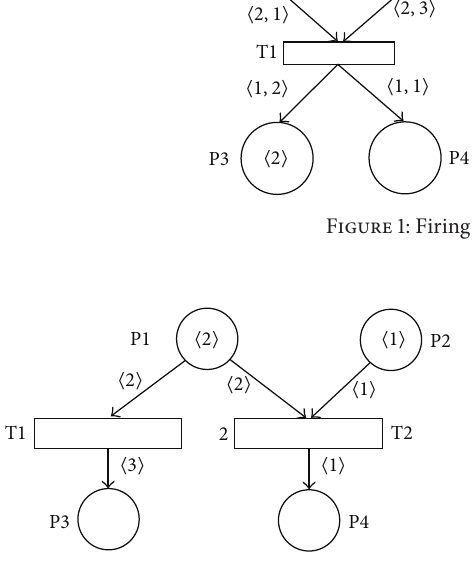
Figure 2: Conflict transitions in SNT Petri net 𝑁2